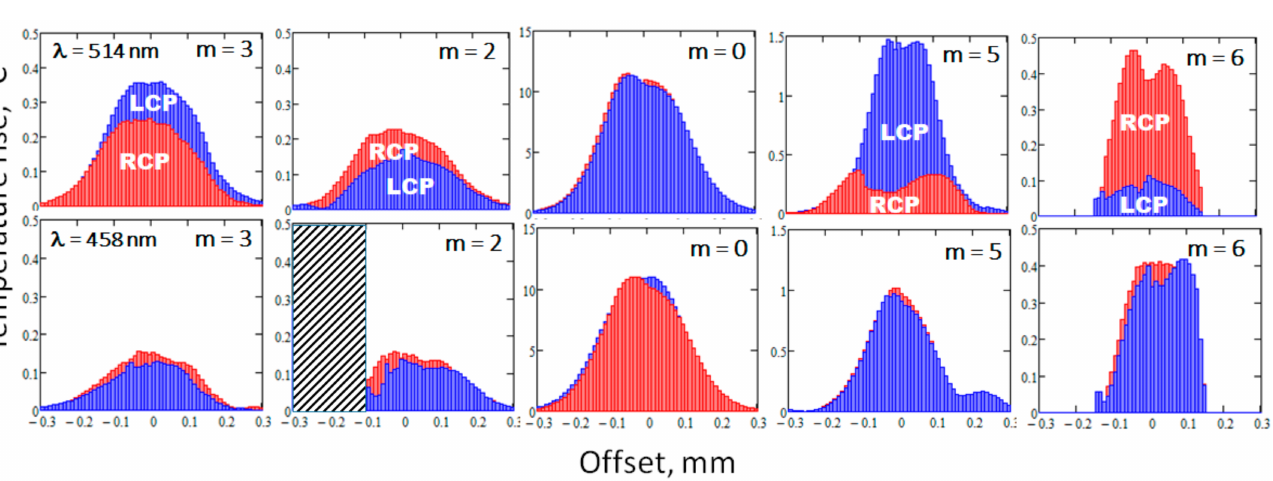
Figure 6. Temperature rise induced by the absorption of the pump beam and diffracted beams and calculated using Equation (8) from the PDT data in Figure 3c at 514 nm, and Figure 3a at 458 nm. The temperature profile is plotted for several diffracted beams. For all figures, the red and blue bars stand for RCP and LCP, respectively.